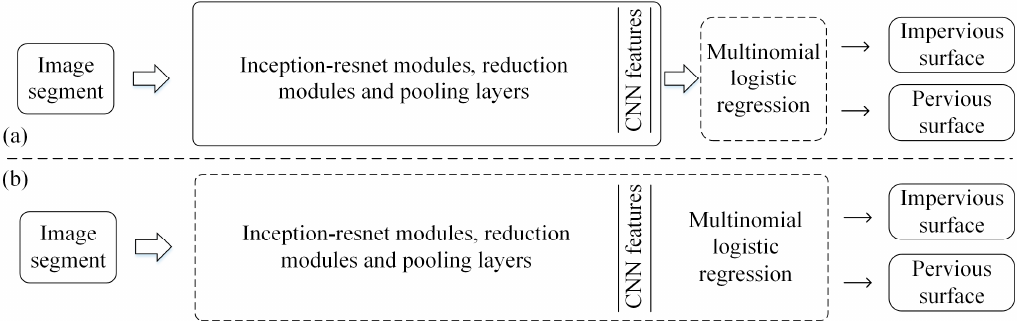
Figure 4. The transfer learning strategies of this study: ( a ) feature extraction and ( b ) fine-tuning. The strategies differ in the trainable part of the pre-training, which is shown in the dotted box.